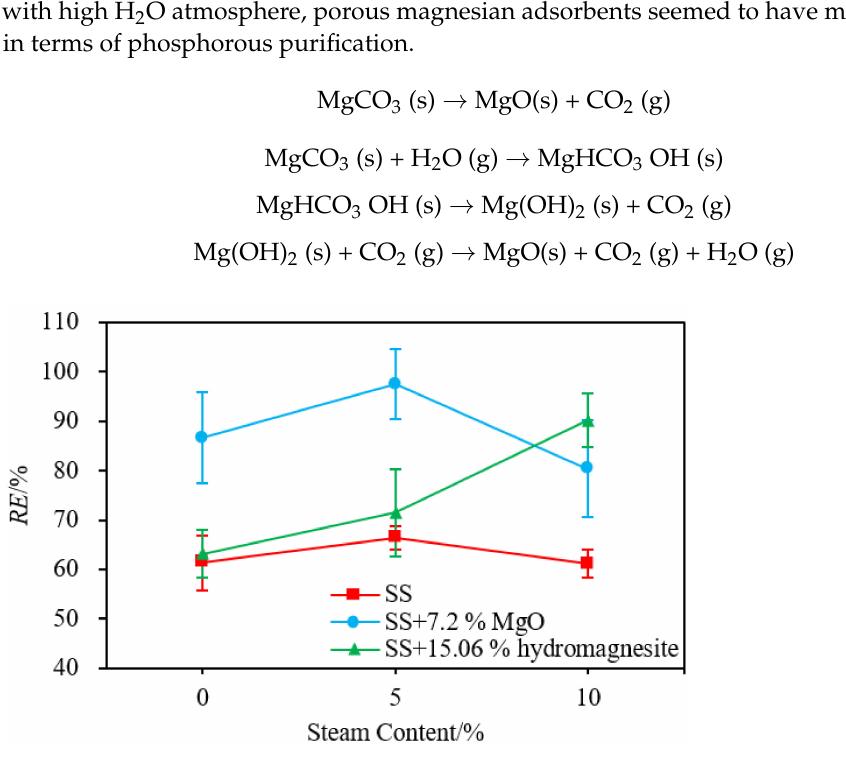
Figure 8. Further improvement of phosphorous RE by hydromagnesite in SS ash during combustion with moisture at 900 ◦